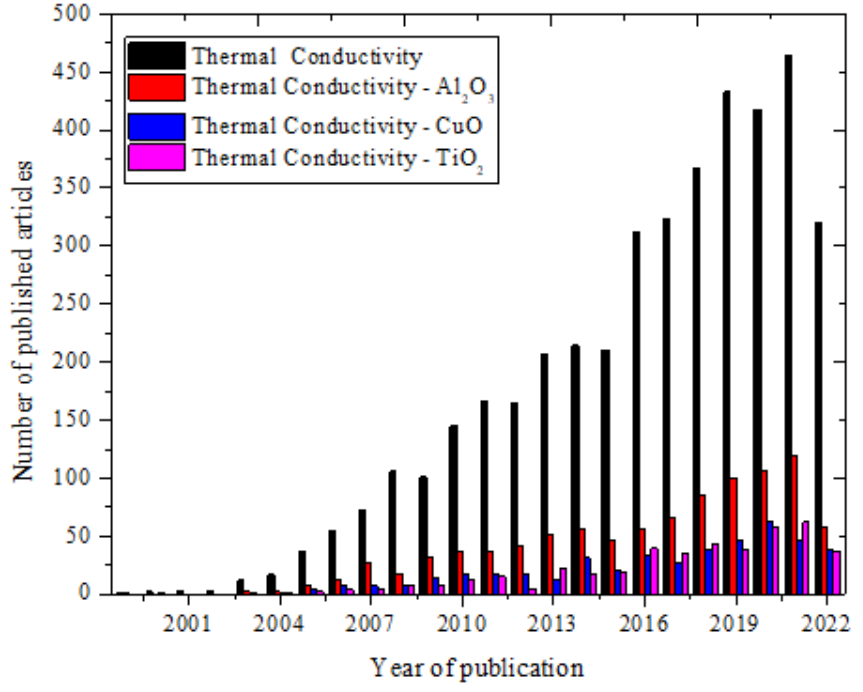
Figure 1. Temporal trend of thermal conductivity of nanofluids, and top metal oxide nanofluids of Al 2 O 3 , CuO, and TiO 2 (Sourced from Scopus database, 31 August 2022).